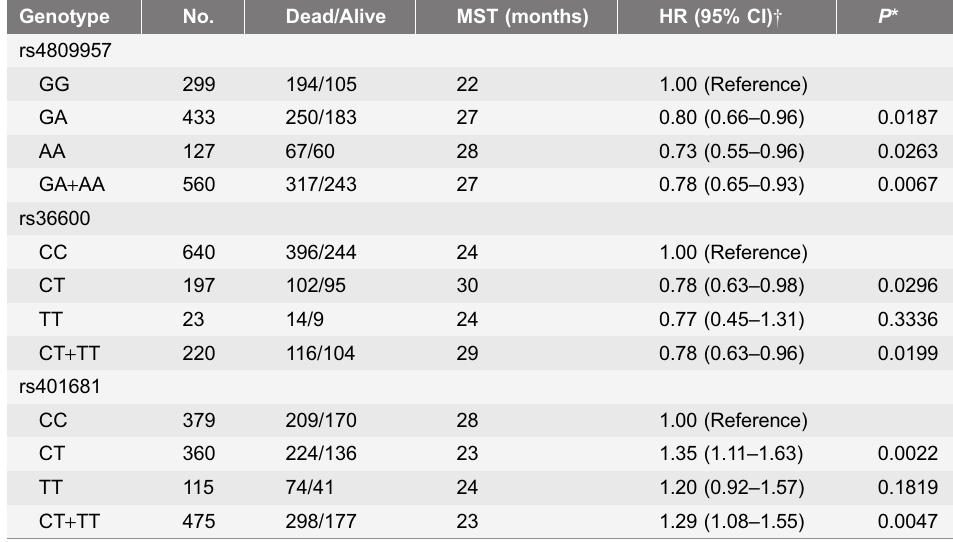
Abbreviation: No., number of patients; MST, median survival time; HR, hazard ratio; CI, confidence interval. Because of genotyping failure of some DNA samples, the number of subjects may not add up to the